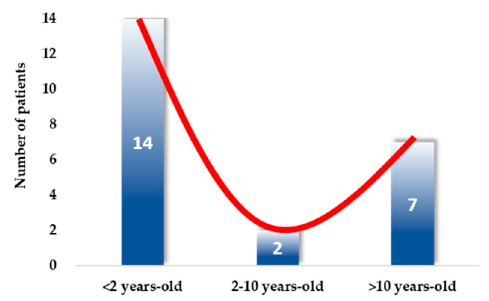
Figure 1. Distribution of children with COVID-19 per age-class. Among the 23 included patients, the majority ( n = 14, 61%) were aged under 2 years old, only 9% ( n = 2) were aged 2–10 years old, and 30% ( n = 7) were over 10 years old. The red line illustrates the distribution across